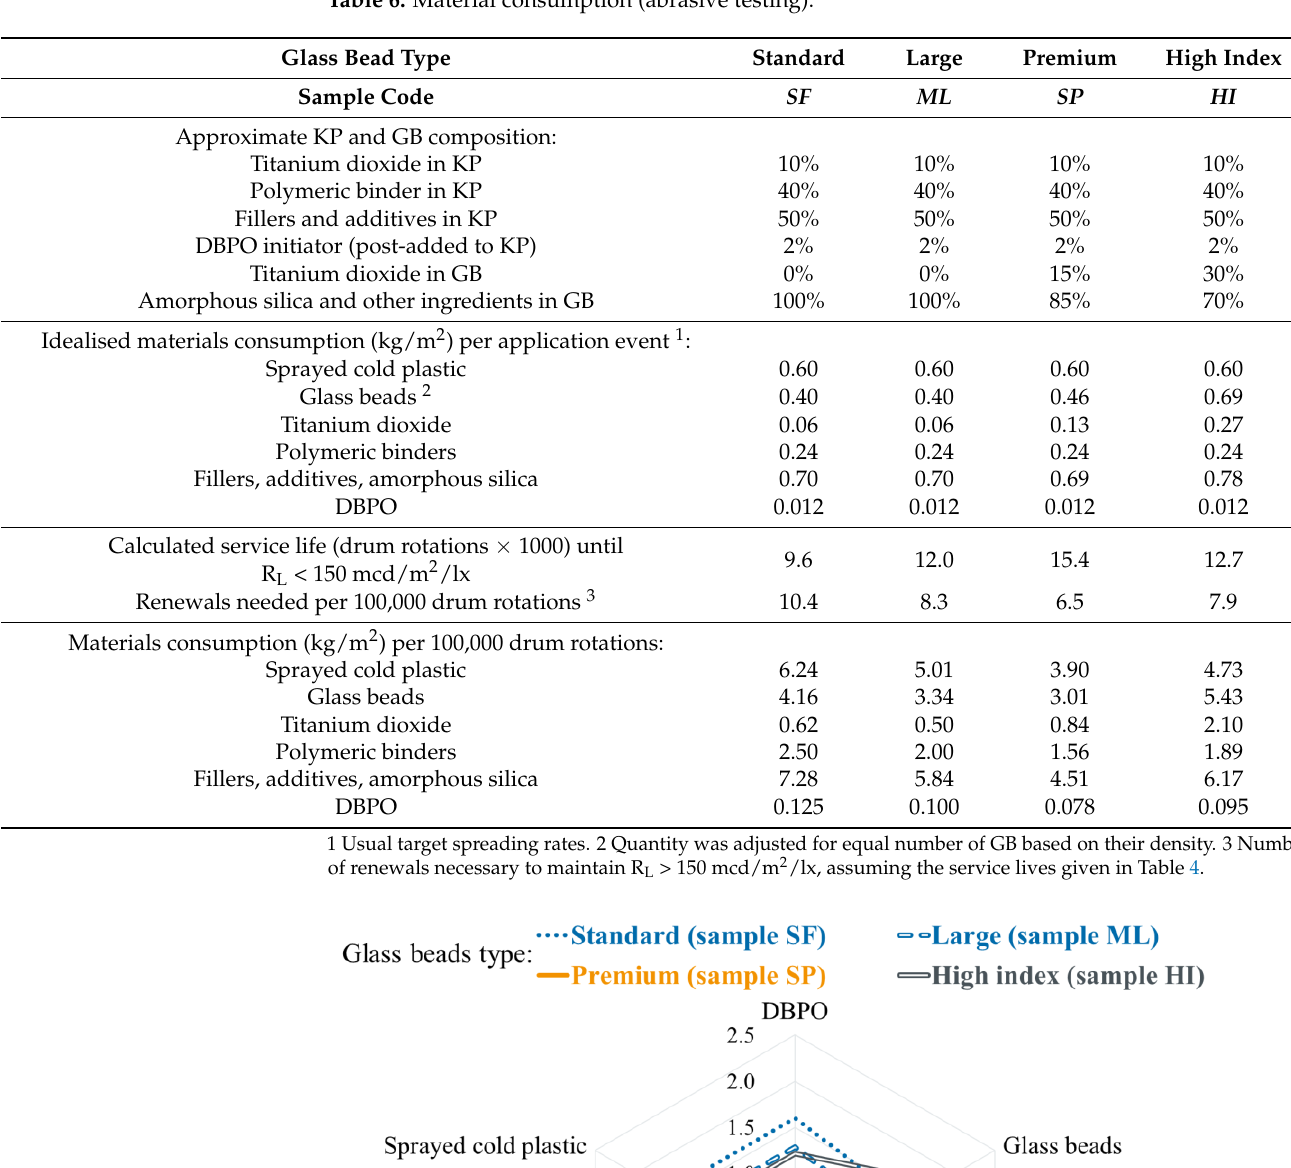
Table 6. Material consumption (abrasive testing).